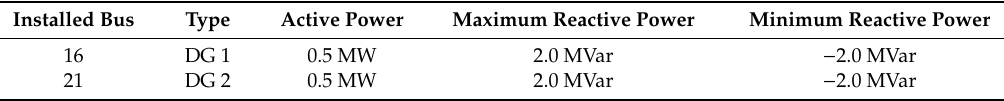
Table 4. Parameters of DGs for case 2.